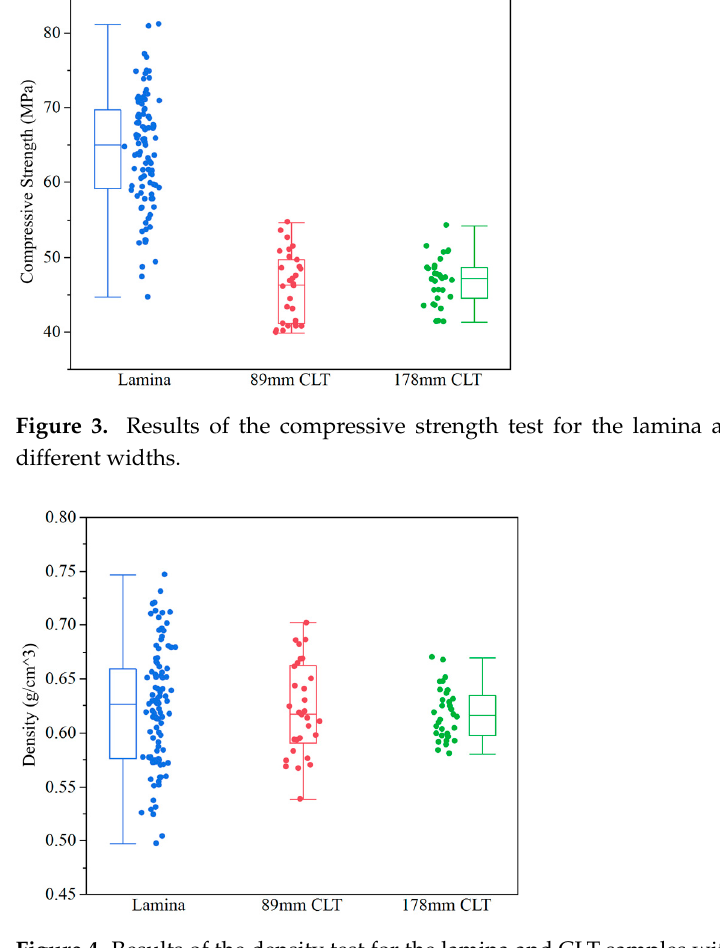
Figure 4. Results of the density test for the lamina and CLT samples with two different widths. Table 2. The statistical tests for the density and compressive strength of the lamina and CLT samples with two different widths. Statistics